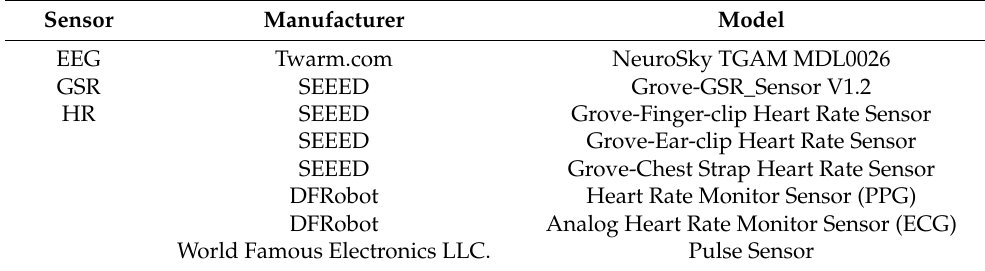
Table 1. Available EEG, HR, and GSR sensors for Arduino makers in the local